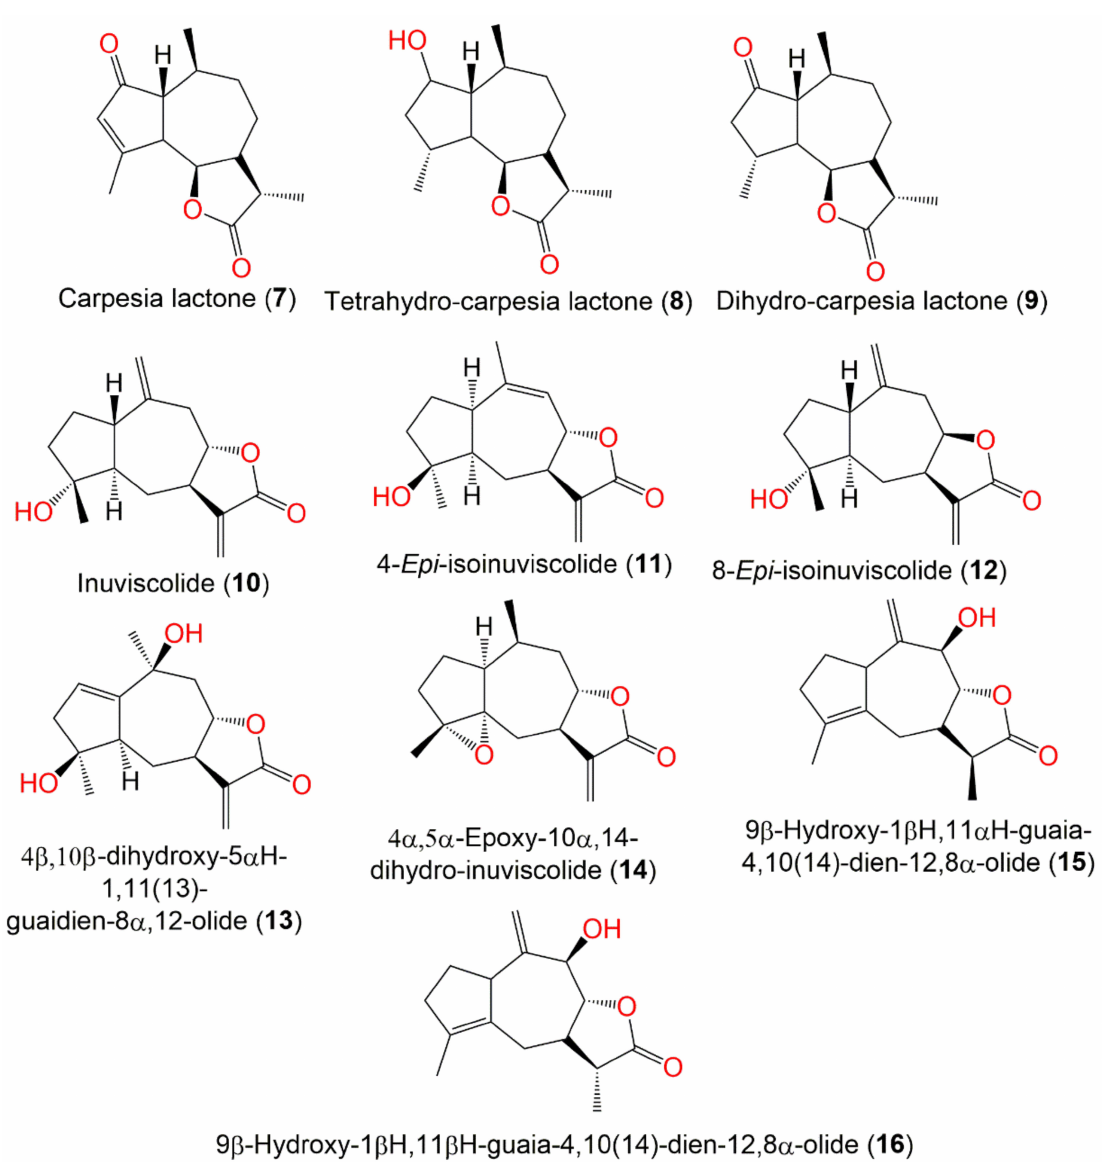
Figure 4. Guaianolide sesquiterpenes ( 7 – 16 ) reported from C. abrotanoides